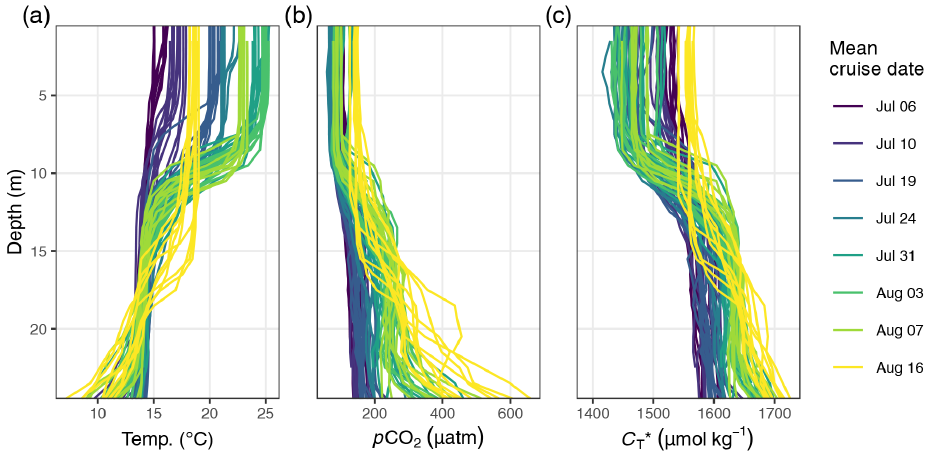
Figure 3. Overview of (a) temperature, (b) p CO 2 , and (c) C ∗ SV Tina V